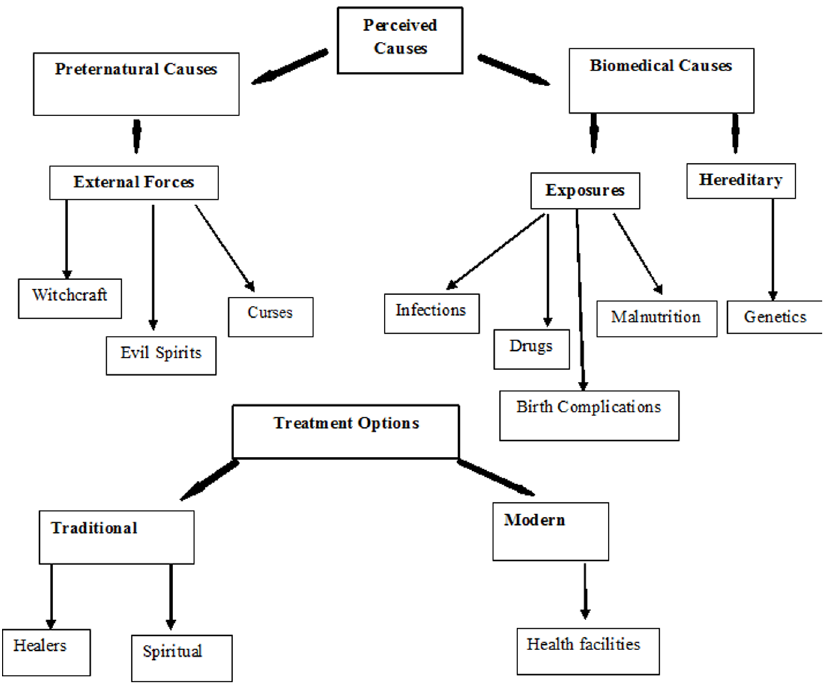
Fig 1. Schematic diagram of themes. Bold arrows point to main themes and sub-themes generated and thin arrows indicate the outcomes from the themes and sub-themes.